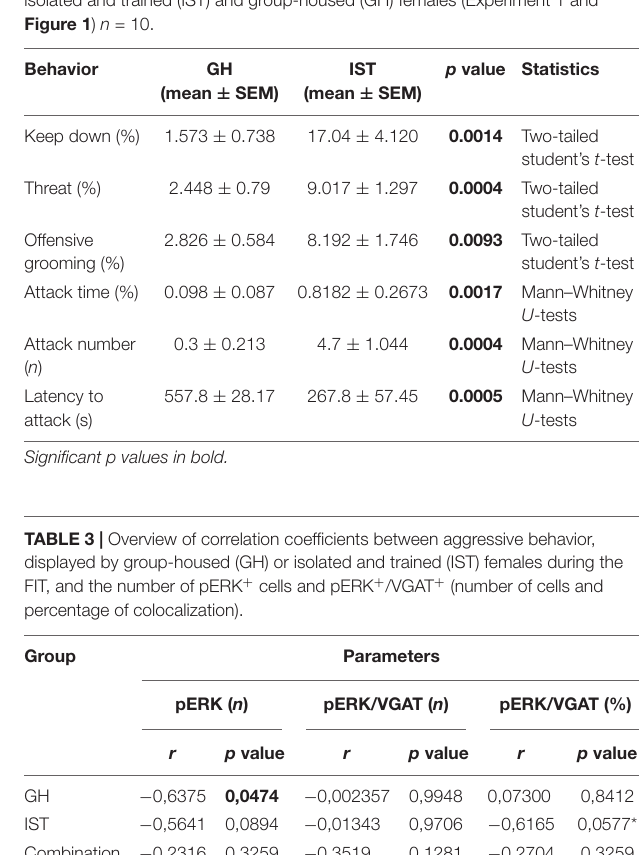
GH and IST data were analyzed via Pearson’s correlation. The combination of the two housing conditions was analyzed via Spearman’s correlation. Significant correlations in bold. *Nearly